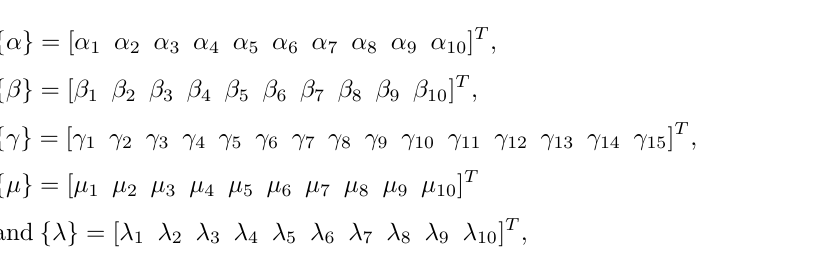
21.741 25.802 28.554